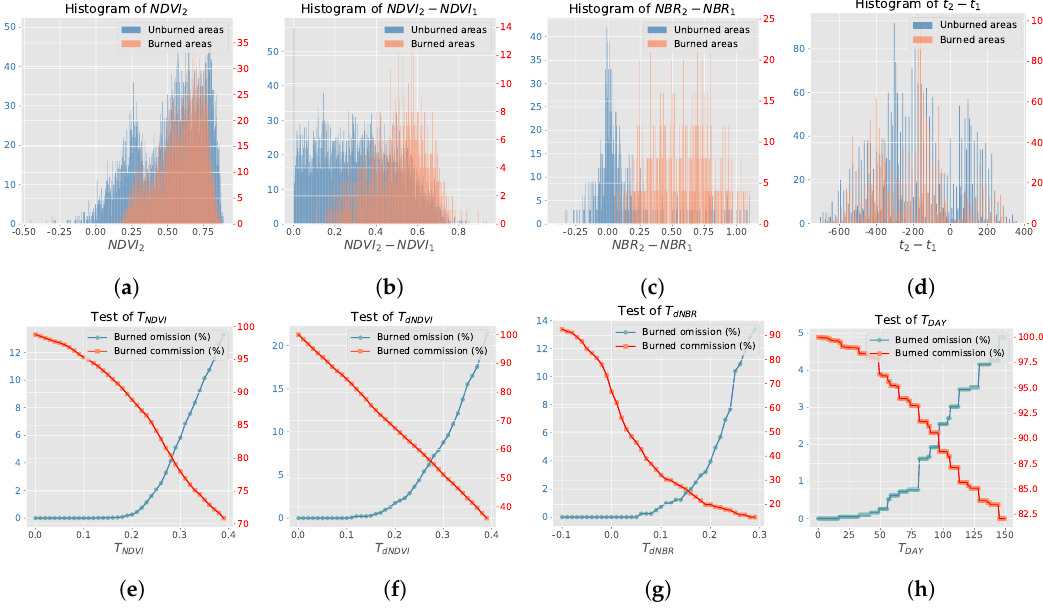
Figure 4. Threshold testing for the filters. ( a – d ) show the histograms of NDVI 2 , NDVI 2 − NDVI 1 , NBR 2 − NBR 1 , and t 2 − t 1 in burned and unburned samples, respectively; ( e – h ) show the percentages of missing burned areas and confused unburned areas when applying various values of T NDVI , T dNDVI , T dNBR , and T DAY ,